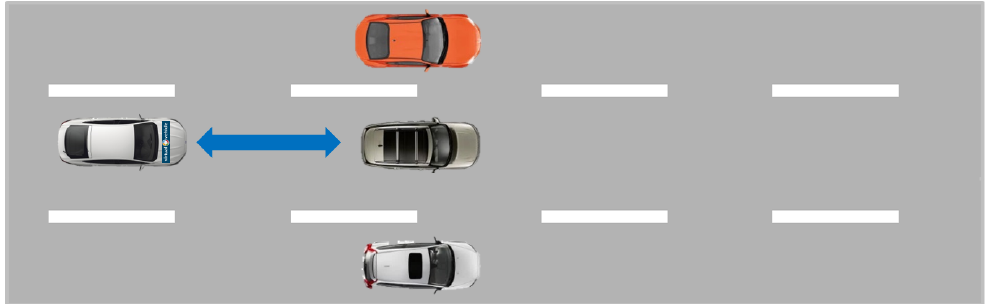
Figure 11. M86 Test Scenario 3 with the ego-vehicle in the rear position.